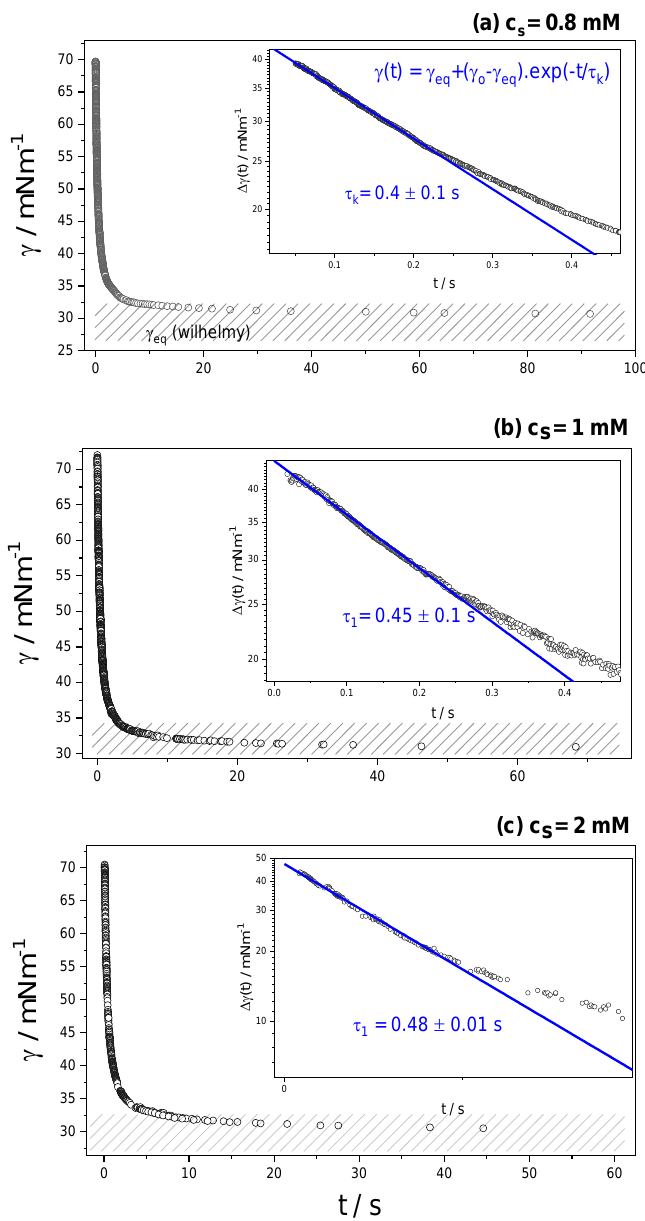
Figure 5. Dynamic surface tension for surfactant concentrations close and above the cmc. ( a ) 0.8 mM; ( b ) 1 mM; ( c ) 2 mM. The insets show the dynamics of adsorption at very short times ( < 0.5 s). The lines are fittings with Equation (5).